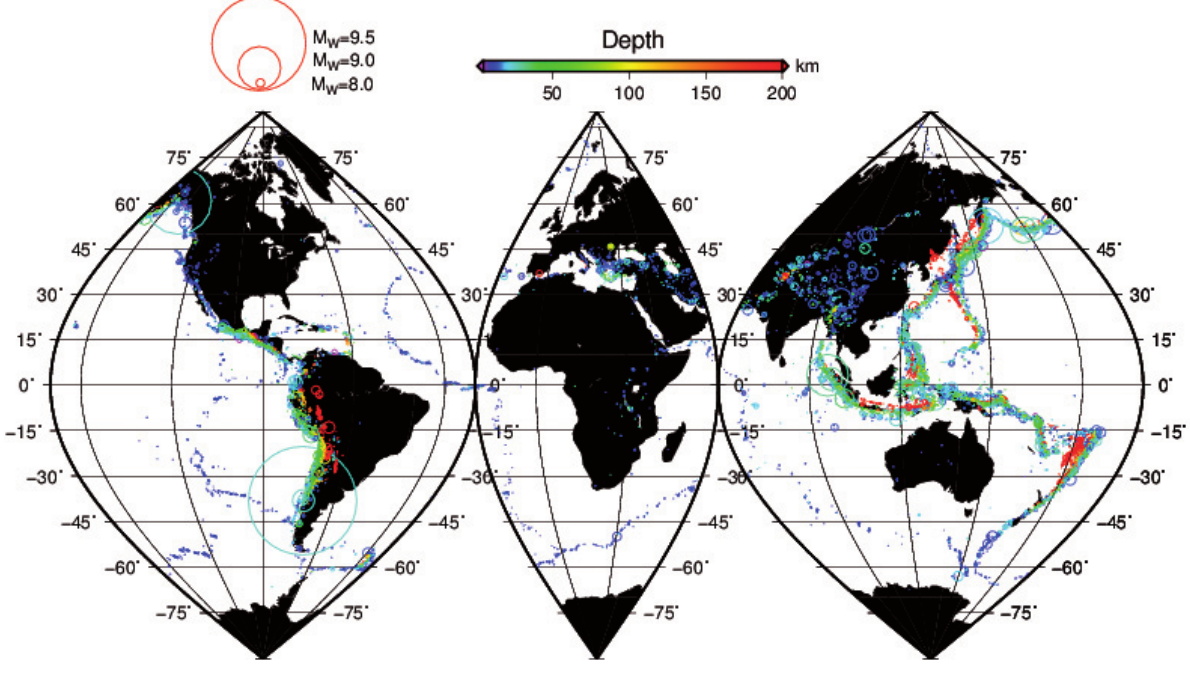
Figure 1. Geographic distribution of the epicenters included in the ISC-GEM catalogue. The color indicates the hypocentral